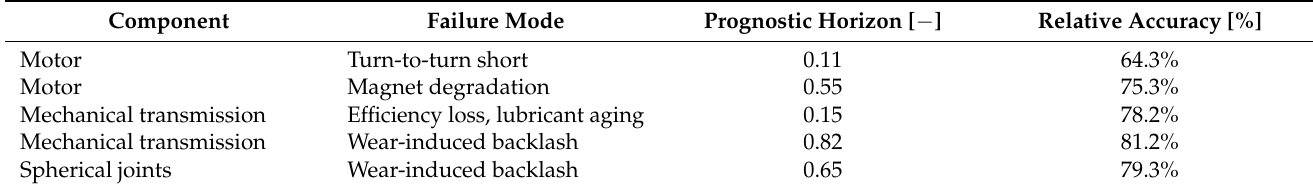
Table 2. Expected performance